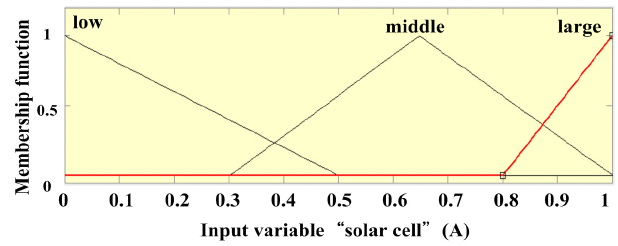
Figure 6. Membership function of the output current.